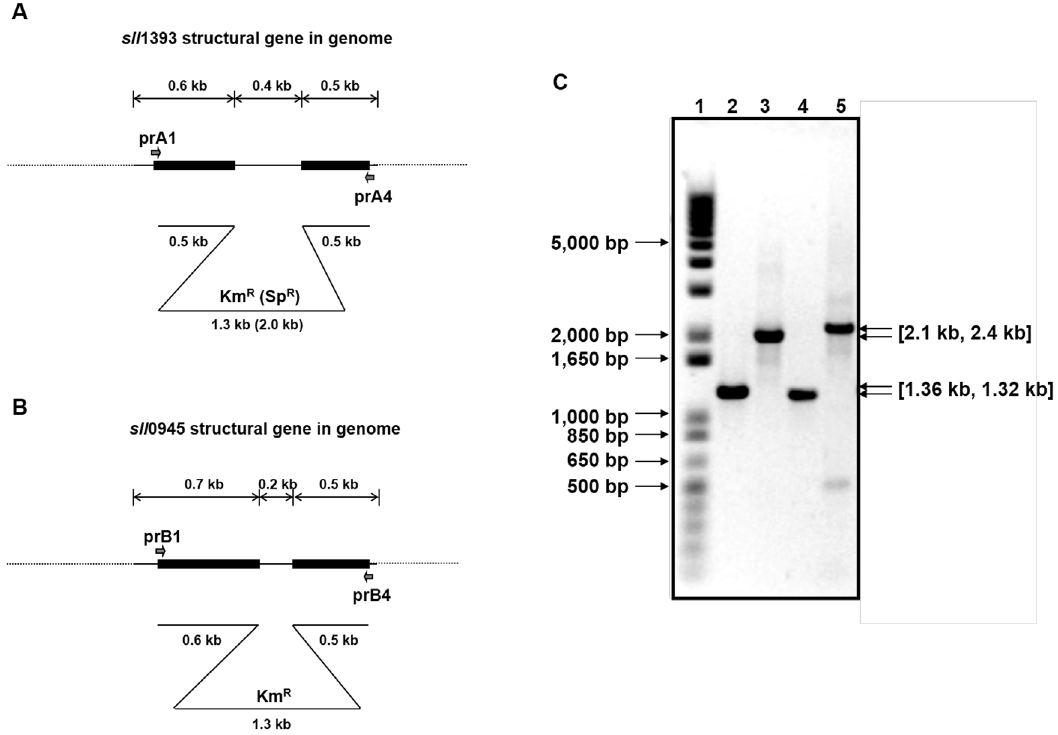
Figure 1. Gene structure of sll 1393 (A) and sll 0945 (B) on Synechocystis sp. PCC 6803 genomic DNA. The targeted replacement of each GS gene with the Km R gene was achieved by homologous recombination. (C) PCR analysis of sll 1393 and sll 0945 genes using genomic DNA from wild- type, sll 1393 2 , and sll 0945 2 strains as templates. For comparison, PCR products of intact genes in wild-type were loaded next (left lane) to the corresponding mutated genes. Lane1 is the size marker (1 kb plus DNA ladder, Life Technologies). DNA bands on lane 2 (WT) and 3 (M1) were amplified using prA1 and prA4; Lane 4 (WT) and 5 (M2) were amplified using prB1 and prB4.